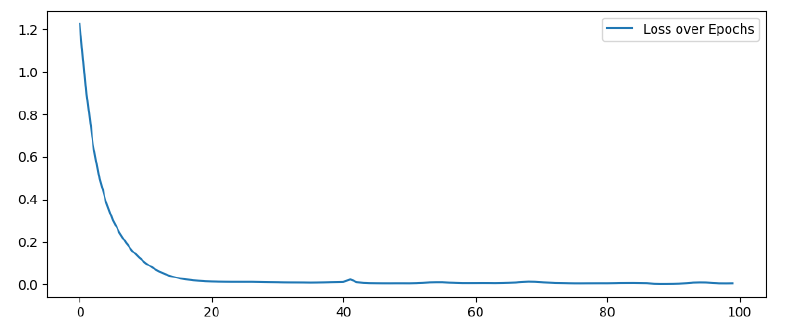
Figure 4. Losses during training over